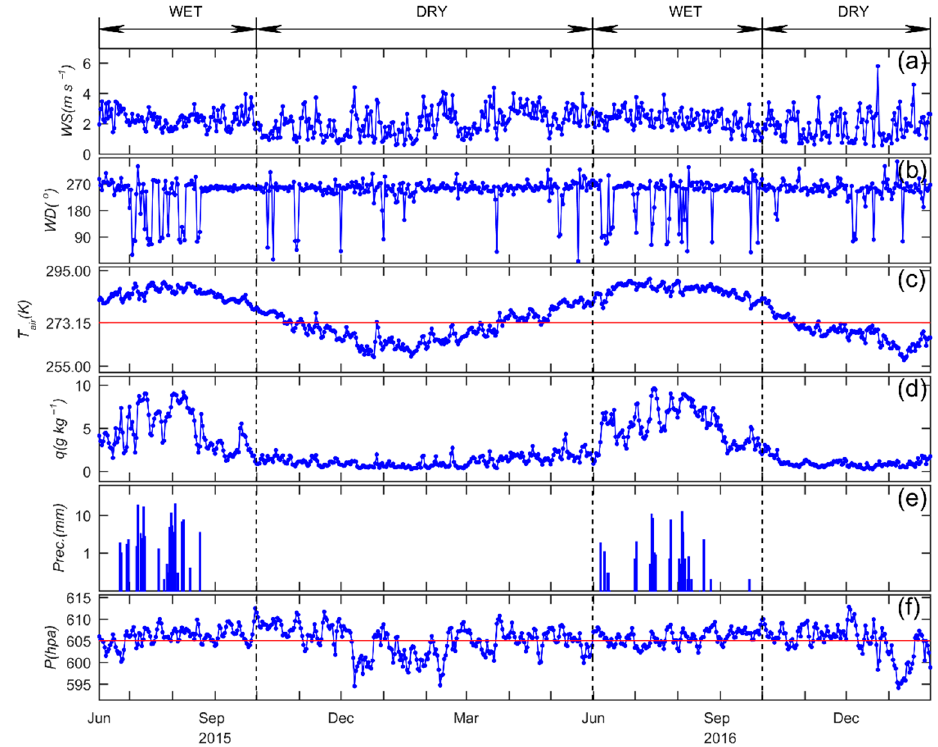
Figure 2. The ( a ) daily mean wind speed ( WS in m s − 1 ), ( b ) daily mean wind direction ( WD in degree), ( c ) daily mean air temperature ( T air in K), ( d ) daily mean specific humidity ( q in g kg − 1 ), ( e ) daily accumulated precipitation ( Prec . in mm), and ( f ) daily mean air pressure ( P in hPa) at the Shiquanhe